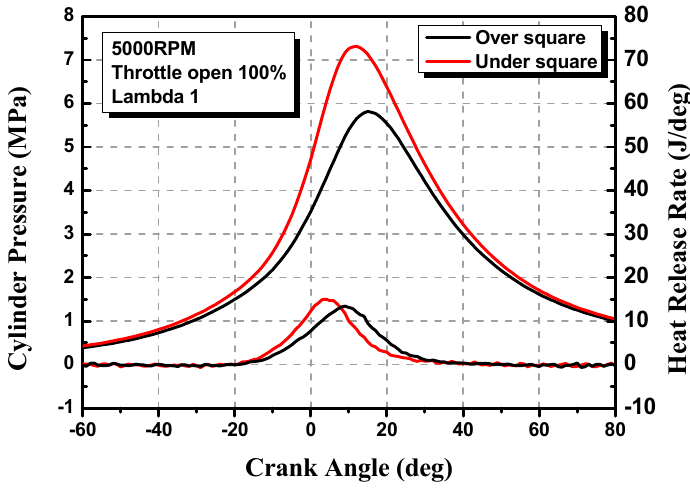
Figure 3. In-cylinder pressure and heat release rates for over- and under-square engines .